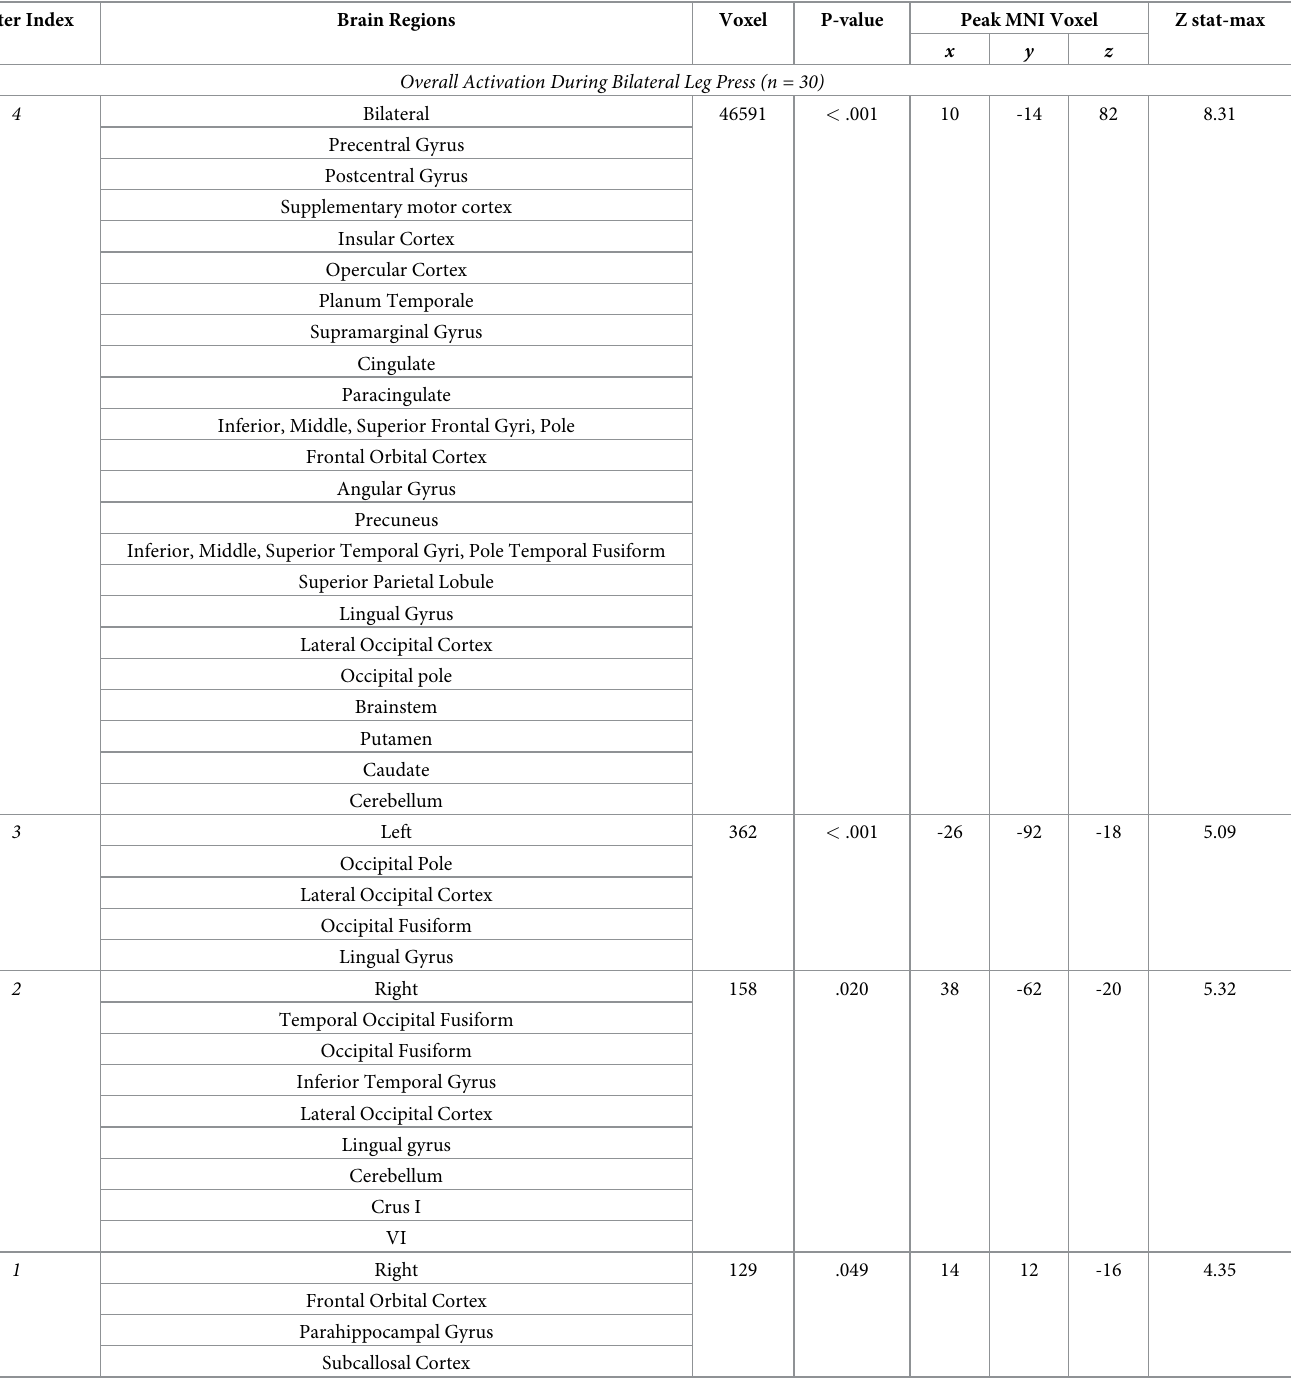
Table 2. Task activity, injury-risk neural correlates and group classification analyses. Cluster